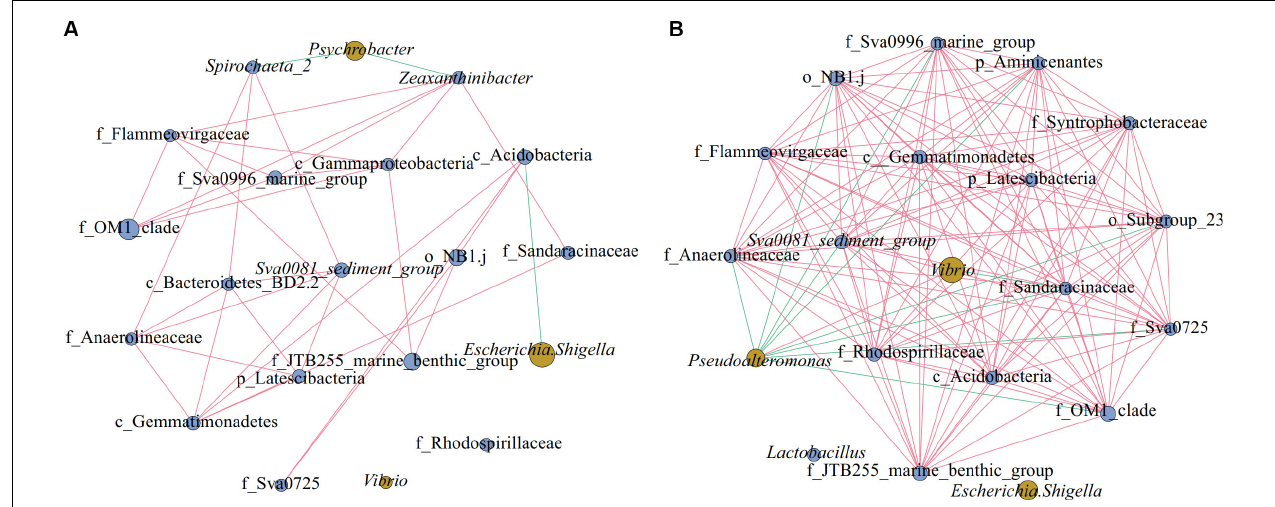
FIGURE 6 | Networks of microorganisms in sediment of different water depths. Co-occurrence of the top 20 genera in sediment of different water depths: (A) Depth L (15–50 m), (B) Depth M (50–70 m). Network diagrams were constructed using 15 (L) and 15 (M) samples; in the group M (50–70 m), we discarded the samples QM17, QM20, and SM36. Blue nodes represent indigenous bacteria and yellow nodes denote pathogenic and pollutants-degrading bacteria. The size of the nodes represents the relative abundance of the bacteria. The edge between the points represents a significant correlation, with the red edge signifying positive correlation and the green edge denoting a negative correlation (Spearman, p < 0.01, r >